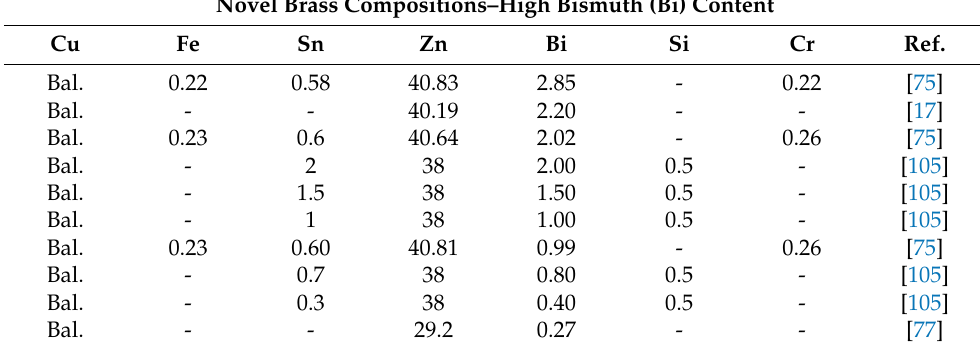
Table A6. Novel brass compositions with an increased bismuth (Bi) content (alloying elements expressed in wt.%).